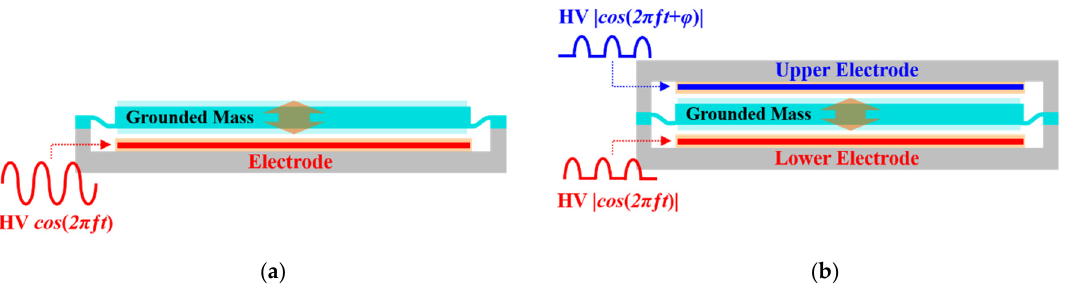
Figure 1. Electrode configuration of: ( a ) single-electrode actuator; ( b ) proposed dual-electrode actuator.